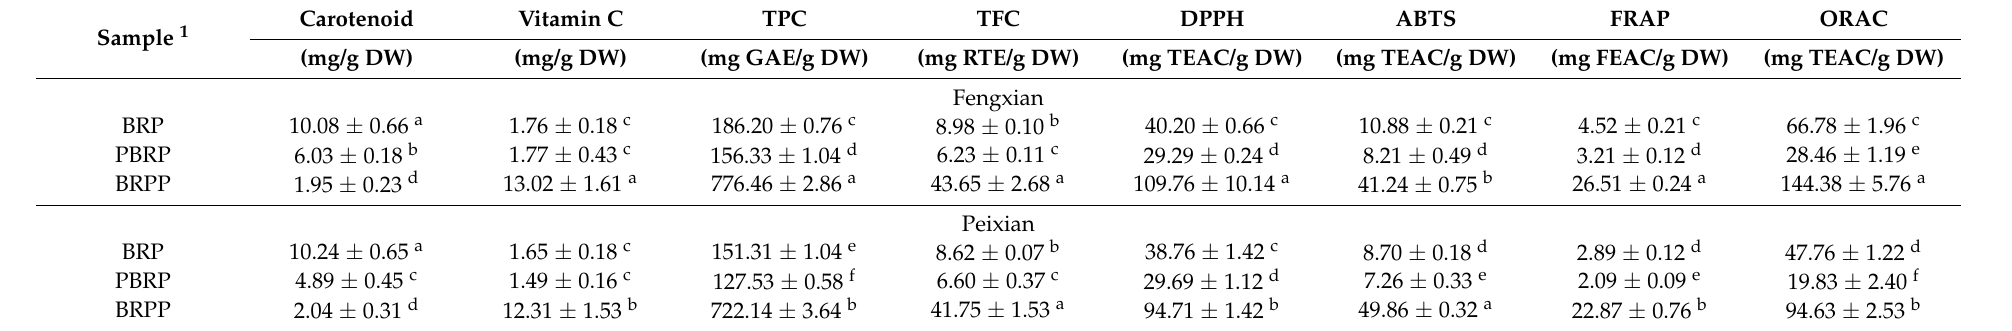
Table 2. Chemical composition and in vitro antioxidant capacity of burdock root samples from Fengxian and